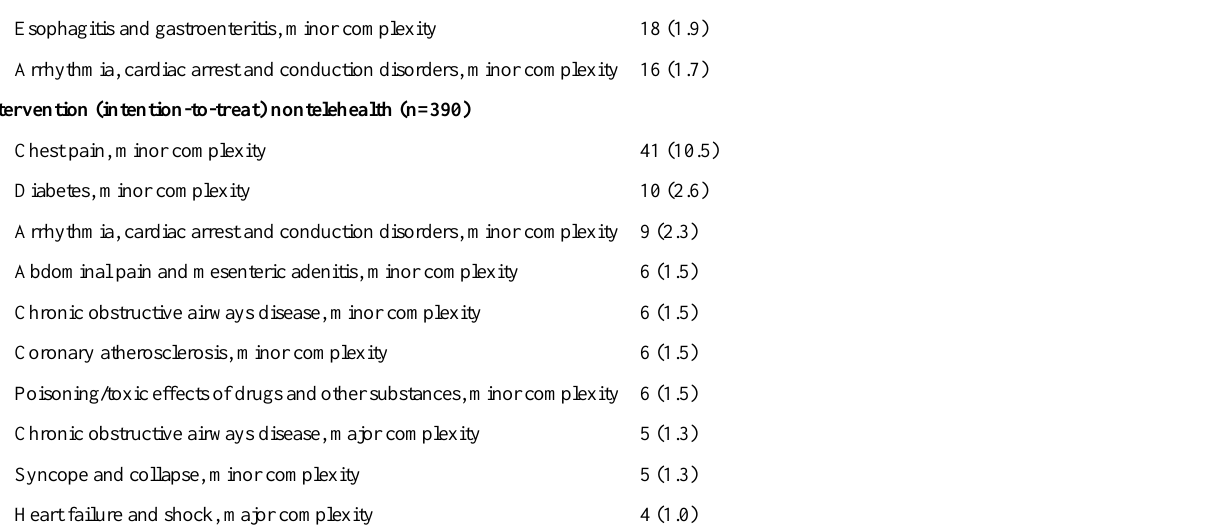
Intervention (intention-to-treat) nontelehealth